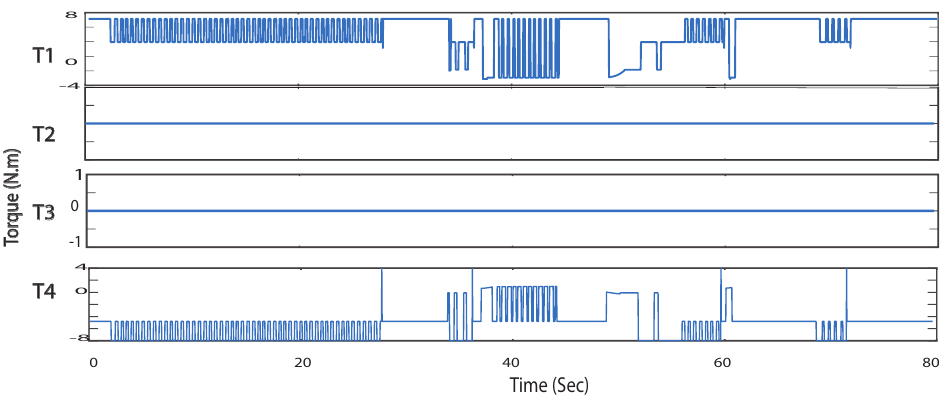
Figure 14. Path of the robot for state 4, state: Right motors are faulty (Wheel 2 and 3).